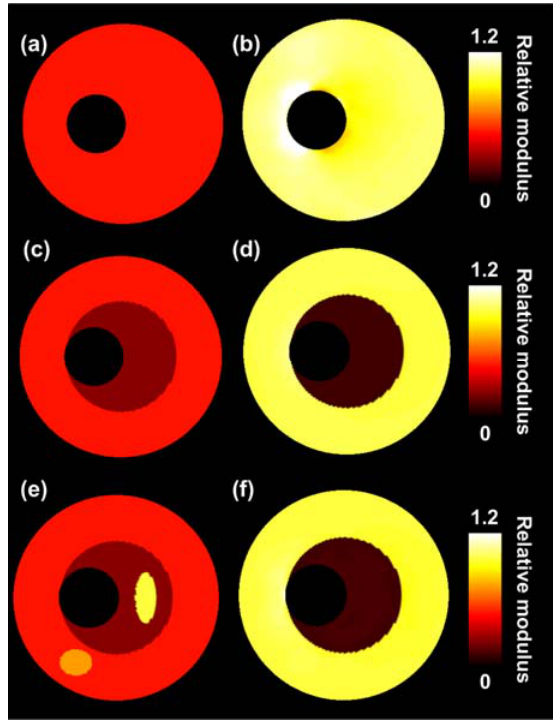
Figure 6. Modulus reconstructions for the heterogeneous two-layered phantom for different soft-prior settings. On the left the regions are shown that were considered to have a different modulus. On the right the corresponding relative modulus reconstruction using soft